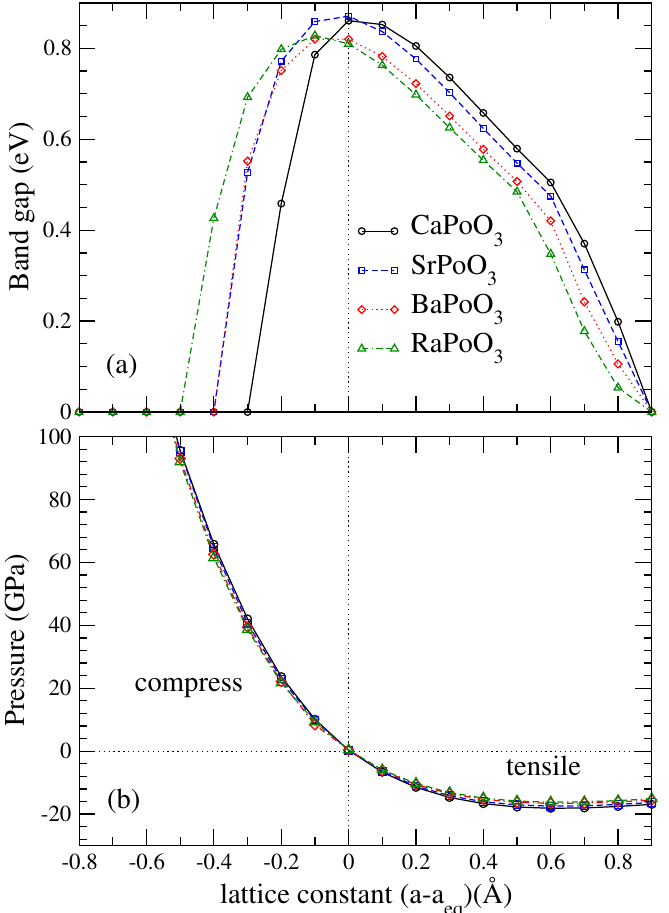
Figure 3. Calculated ( a ) fully relativistic band gap, in eV, and ( b ) external pressure (GPa) as a function of the lattice constant with respect to its equilibrium lattice constant a eq